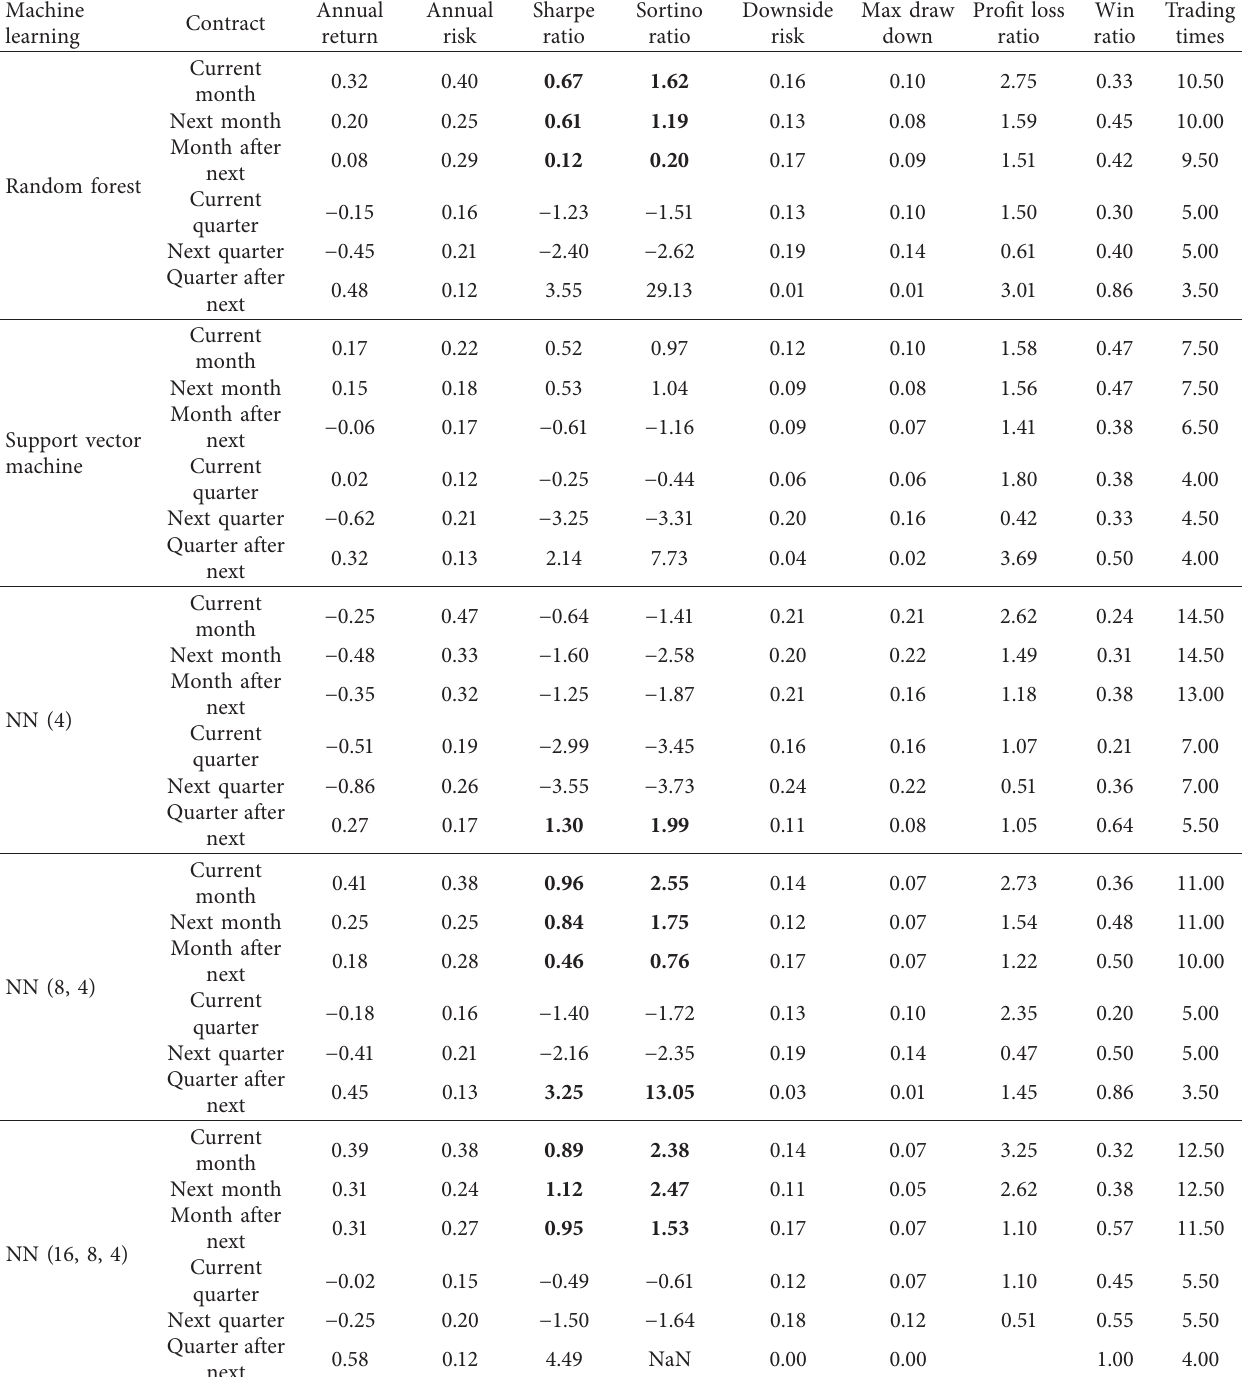
Table 20: Investment evaluation on test data set with parameters [0.05, −